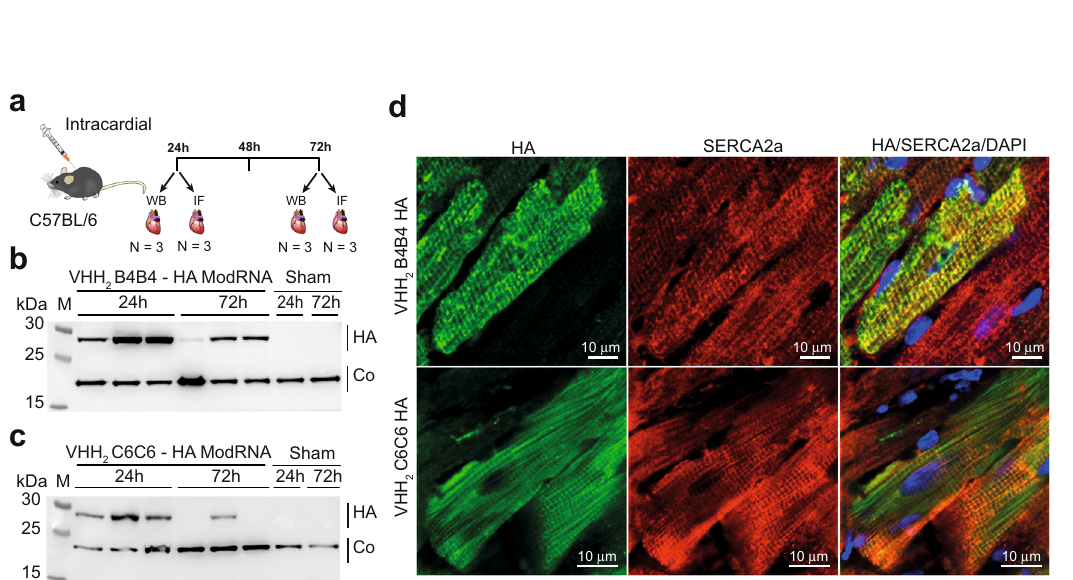
Fig. 3 Effects of the modRNA-encoded intrabodies on the Ca 2 + dynamics of rat neonatal cardiomyocytes. Top panels show representative Ca 2 + transients for the different groups: a cells transfected with modRNA encoding VHH B4 ( n = 53); b cells transfected with modRNA encoding VHH 2 B4B4 ( n = 70); c cells transfected with modRNA encoding VHH C6 ( n = 129); d Untransfected control cells ( n = 66). e – h Individual data points (open circles) and average value (bar graph) of e T 50 (peak half-width), f 1/ τ (rate of transient decay), g d F/ d t up (the upstroke velocity) and h Δ F / F 0 max (the amplitude of the Ca 2 + transient) for the control and treated cells with modRNA encoding for the different intrabodies (indicated on the X -axis): VHH B4 ( n = 53); VHH C6 ( n = 129); VHH B4B4 ( n = 70); and untransfected control cells ( n = 66). Error bars represent the standard error of the mean (SEM) in the sample set. Two data points in the VHH C6 Ca 2 + transient amplitude data with values above 2.0 were omitted from the graph in panel h for clarity. Statistical signi fi cant differences with the control group are indicated and were evaluated using one-way ANOVA using all data points and assuming normal distributions. Two-tailed post-hoc Tukey-Kramer P -values were calculated, and signi fi cance values for differences with the control group are indicated: ** P -value < 0.01, **** P -value < 0.0001. Exact P -values are given in Supplementary Table 3. i Post-calcium imaging immuno fl uoresence images of fi xed and permeabilised transfected cardiomyocytes (anti-PLN, green; anti-HA tag, red). White arrows indicate cells showing clear co-localisation and perinuclear staining for both the anti-HA antibody recognising the expressed intrabody and the staining originating from the 2D12 antibody for PLN staining. Immuno fl uorescence experiments of transfected rat neonatal cardiomyocytes have not been independently repeated. A.U. arbitrary units. Source data